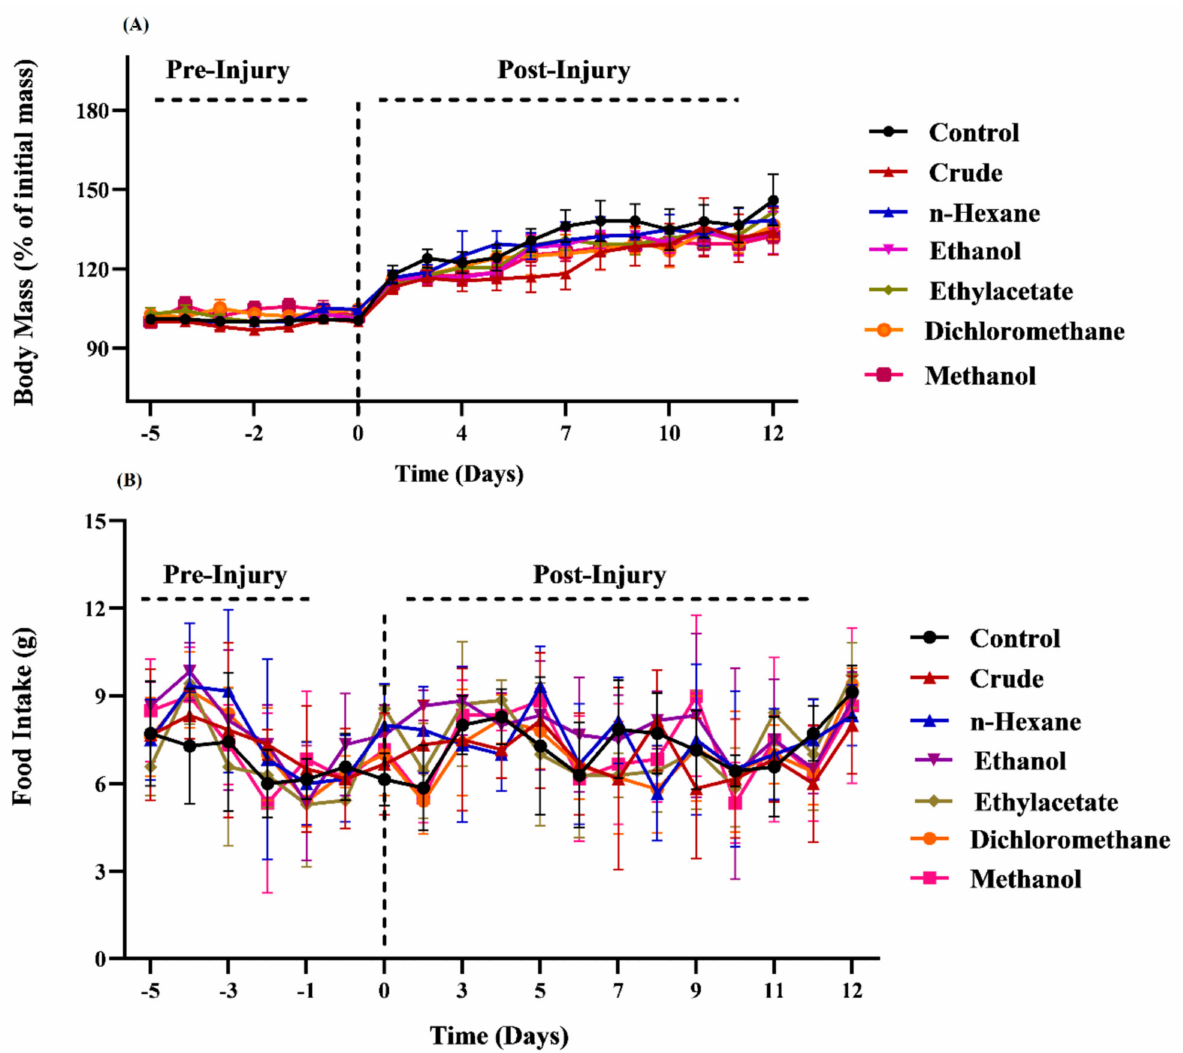
Figure 1. Impact of M. oleifera on ( A ) mouse’s body mass ( B ) food intake